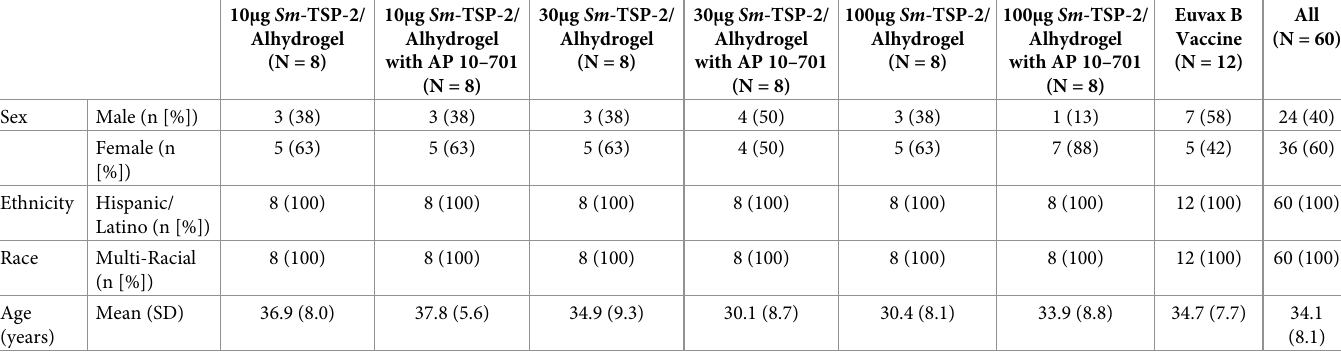
Table 1. Demographic and baseline characteristics of study participants by vaccine